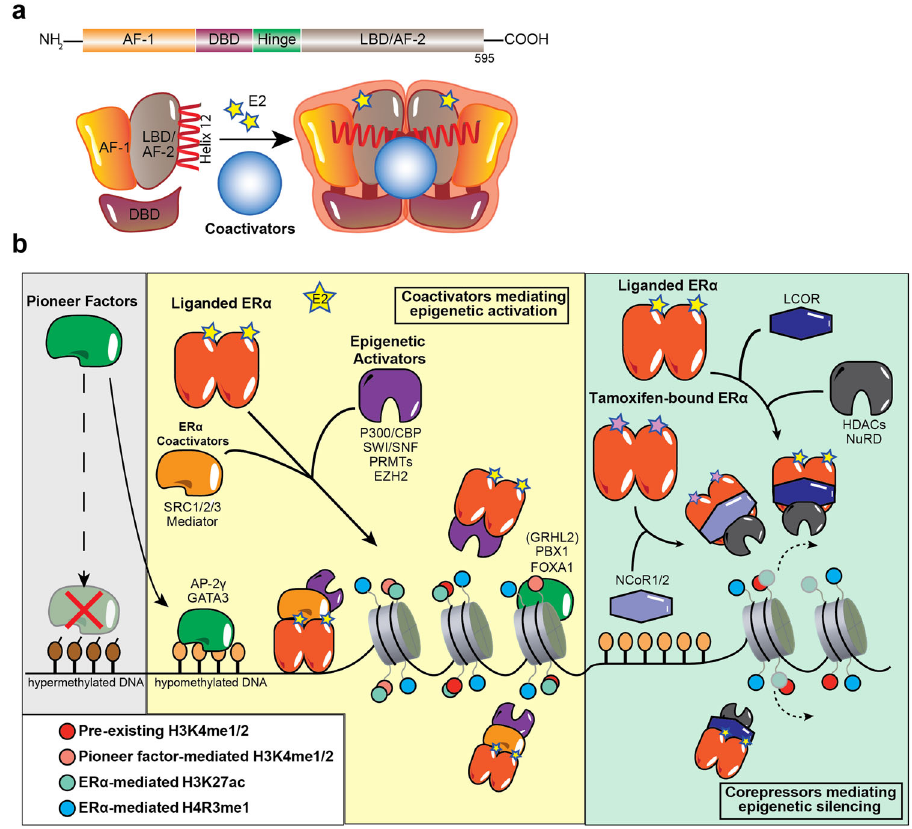
Fig. 1 ER α mediates epigenetic changes by interacting and crosstalking with pioneer factors and co-regulators. a Schematic depiction of various structural domains within the estrogen receptor (ER α ). The LBD harbors surfaces for dimerization as well as coactivator binding. Upon binding E2, helix 12 within the LBD shifts to an active conformation, which promotes ER α interaction with coactivators. b Pioneer factors such as FOXA1, GATA3, PBX1, and AP-2 γ preferentially bind to hypomethylated genomic sites bearing their respective motifs. Importantly, these sites are often already marked with low levels of H3K4me1/2, which increase with the recruitment of pioneer factors such as FOXA1. Upon stimulation with the E2 ligand, pioneer factors facilitate the localization of liganded ER α to the chromatin. This leads to the activation of gene expression as ER α recruits epigenetic activators such as P300/CBP, the SWI/SNF complex, PRMTs and EZH2 (through direct contact or through coactivators such as SRC-1/2/3 and Mediator) to deposit activating epigenetic marks such as H4R3me1 and H3K27Ac (solid-colored). However, through interactions with corepressors such as LCOR and NCoR1/2, liganded ER α and tamoxifen-bound ER α can also recruit epigenetic repressors including HDACs and the NuRD complex to mediate gene repression by removing active epigenetic marks (faintly